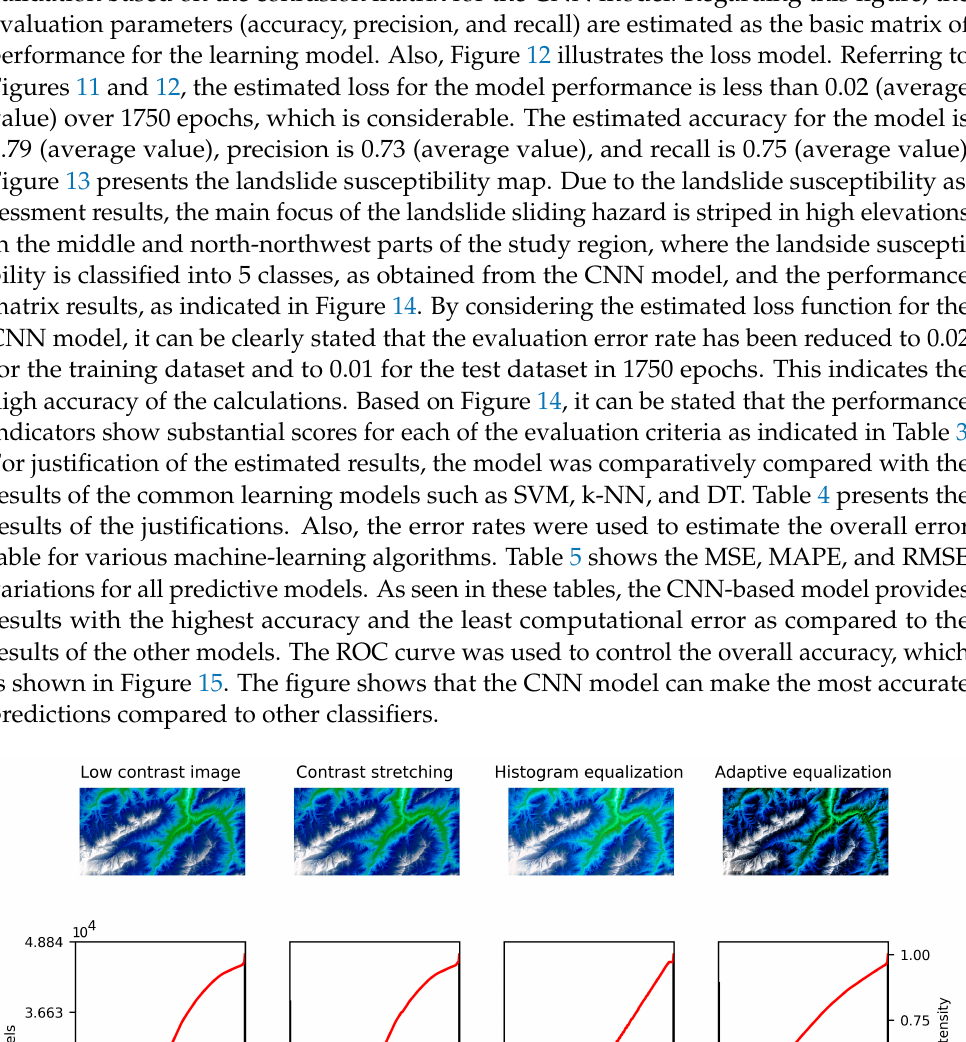
Figure 10. The overlaying results of convolution implementation (CNN-based relevance maps) to estimate the region landslides susceptibility.